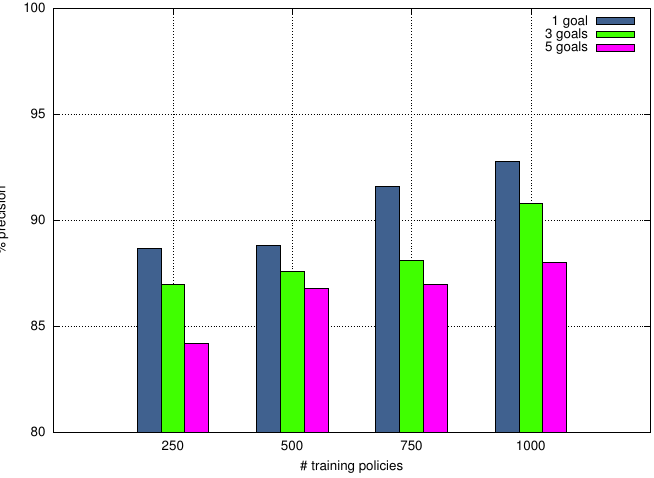
Figure 11. Precision vs. Training Policies.